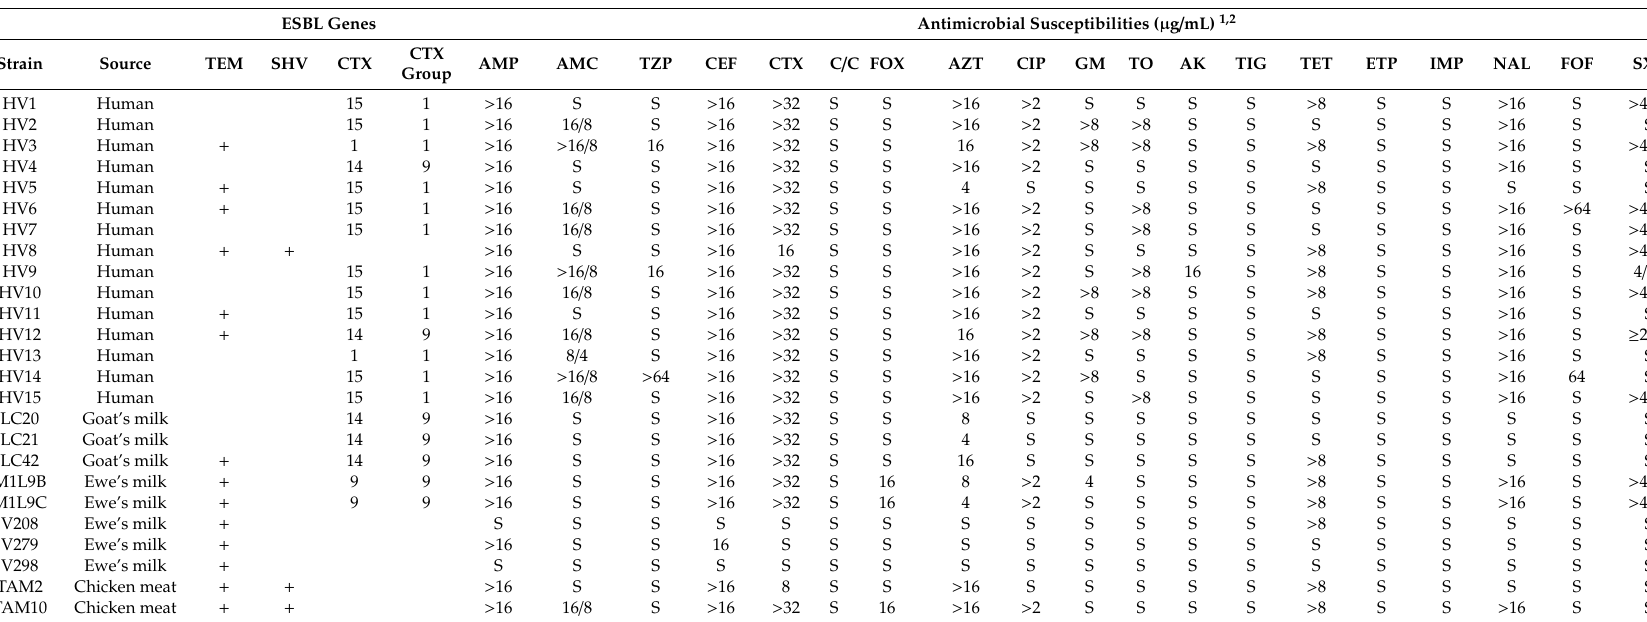
Table 1. Genetic characteristics and antimicrobial susceptibilities of extended spectrum β -lactamases (ESBL)-producing E. coli from human and food origins. ESBL Genes Antimicrobial Susceptibilities ( µ g / mL) 1,2